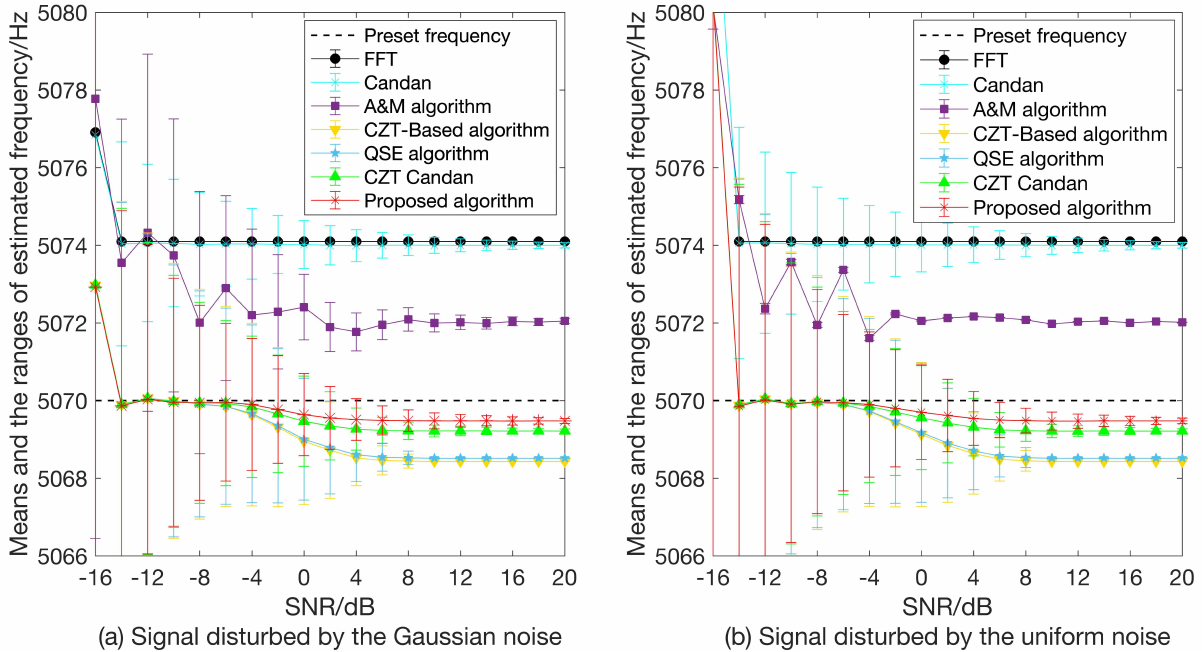
Figure 2. Means and variation ranges of frequency estimates of various methods versus SNR when f c = 5070 Hz.